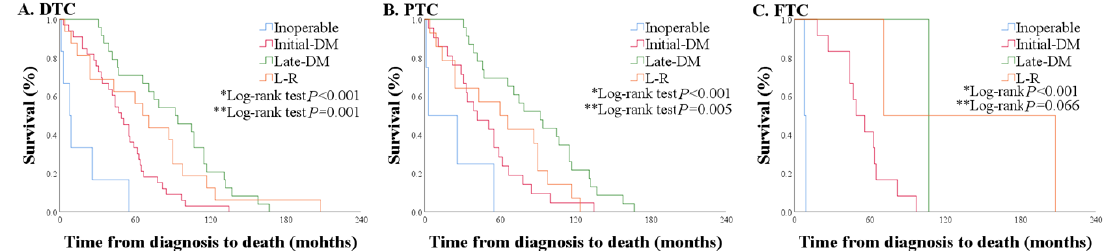
Figure 2. Overall survival according to clinical course in patients with ( A ) all well-differentiated thyroid carcinoma (WDTC), ( B ) papillary thyroid carcinoma (PTC) only, and ( C ) follicular thyroid carcinoma (FTC) only (* comparison of the inoperable, initial distant metastasis (DM), late-DM, and L-R groups, ** comparison of the initial-DM, late-DM group, and L-R groups).